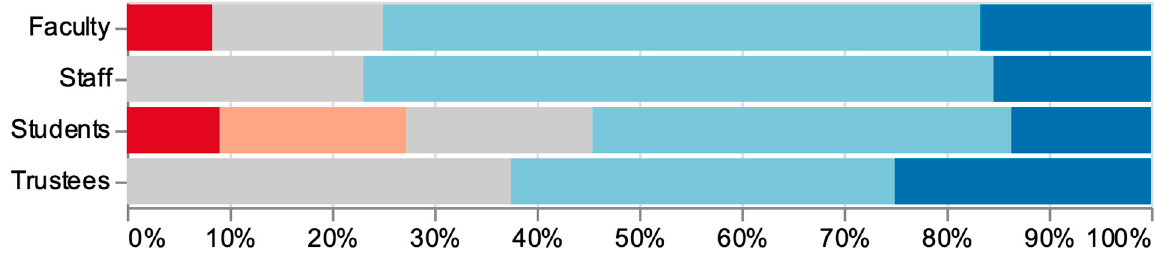
Figure 4. “Bivocational ministry is an intentional career path for ministry”. (Q6). 5% strongly disagree; 7% disagree; 22% neutral; 49% agree; 16% strongly